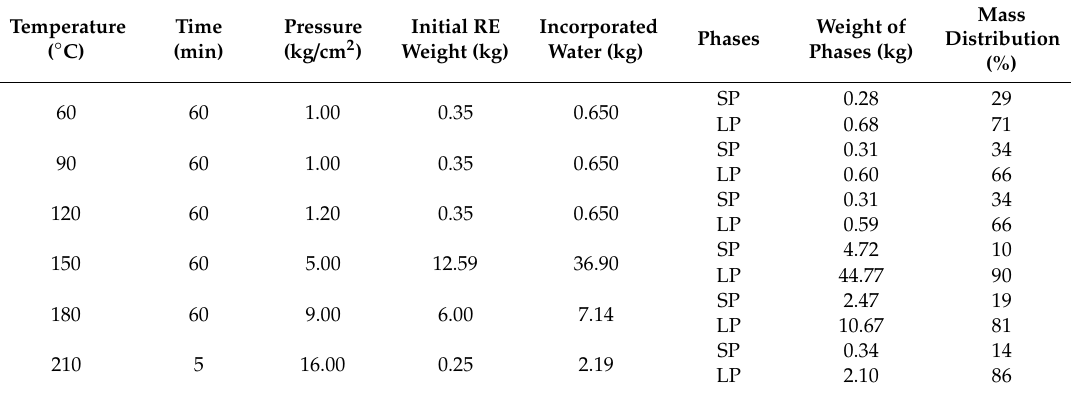
Table 1. General data about the mass distribution after each hydrothermal